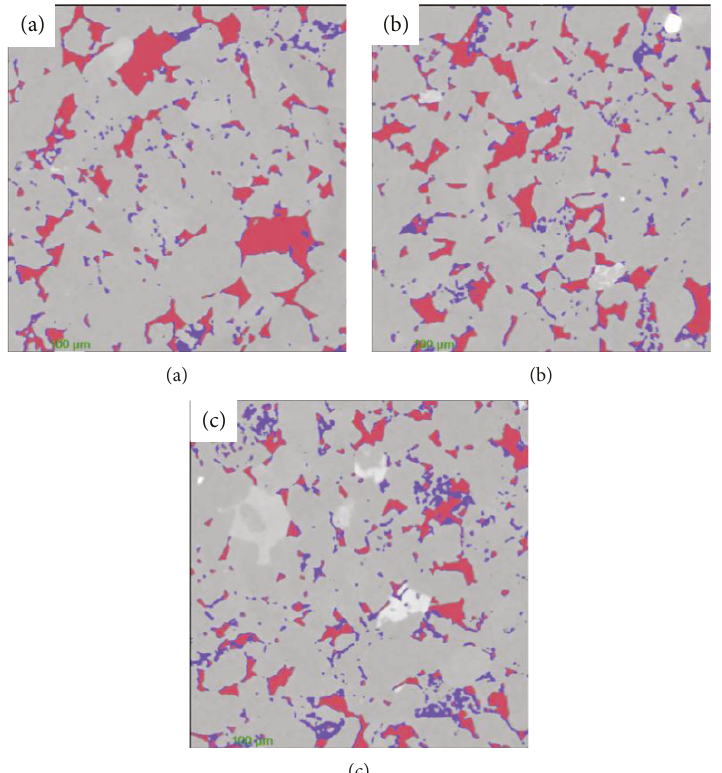
Figure 7: Distribution of irreducible water saturation of a given slice with the same areal porosity (void space): (a) S = 36 37% (slice number: 425); (c) S number: 362); (b) S swi blue=irreducible water; red =oil.